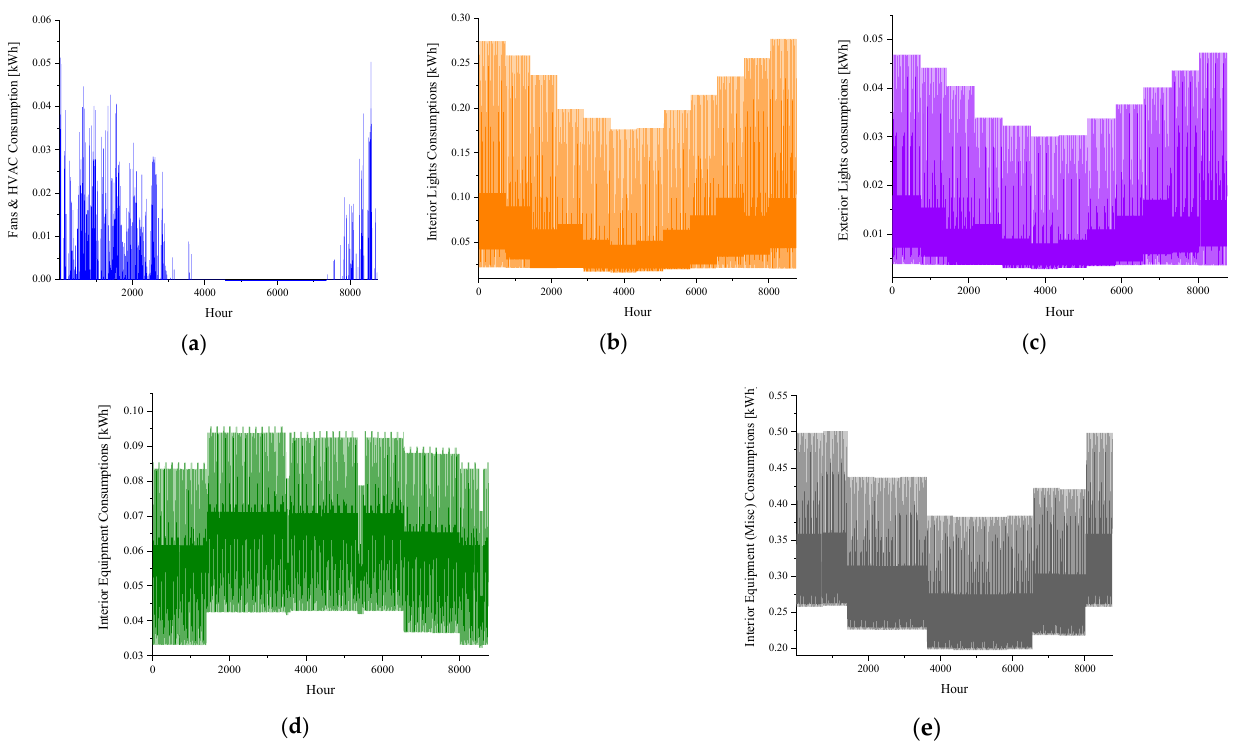
Figure 7. Electric load profiles based on the type of the consumer ( a ) fans and HVDC consumptions; ( b ) interior lights consumptions; ( c ) exterior lights consumptions; ( d ) interior equipment consumptions; ( e ) interior equipment (misc) con- sumptions.